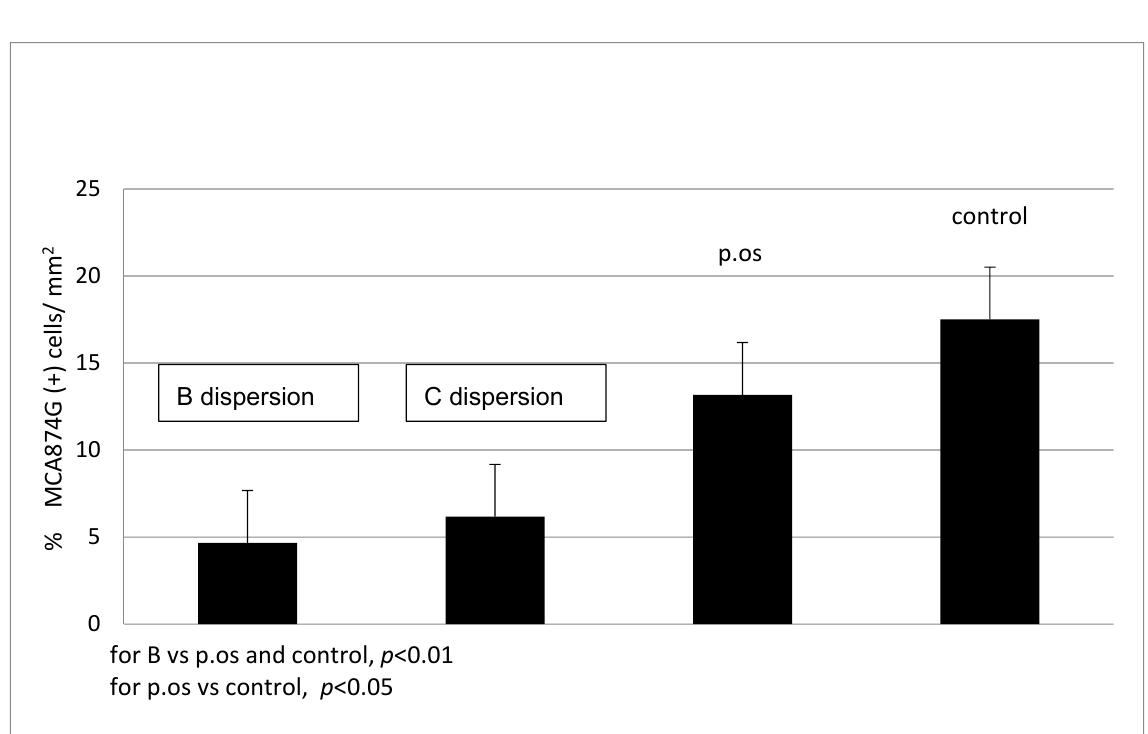
Figure 8. The presence of macrophages in the vessel wall (aorta) after 7 days (groups receiving B and C SVPLA vs. p.os and control). SVPLA dispersion concentration; B: 0.1750 mg/mL, C: 0.0875 mg/mL. SV orally 0.6 mg/kg; Control; saline 0.9% NaCl. Each group n = 6; six vascular samples (aorta) were tested per animal (total 36 per group).